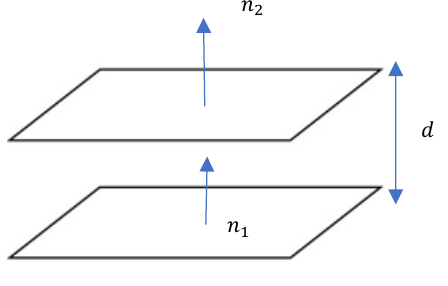
Figure 4. 𝒏 𝟏 and 𝒏 𝟐 are nearly the same but vertical distance of these planes is large. So, these two planes are different and none of them should be deleted .